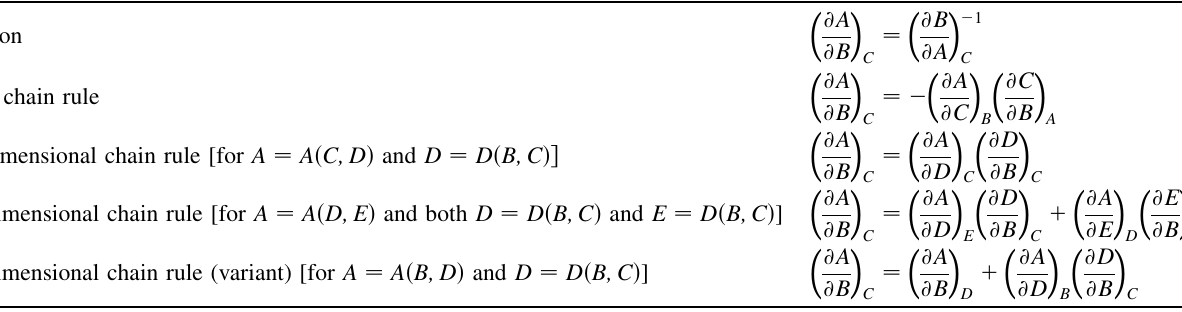
TABLE IV. Several common partial derivative rules.